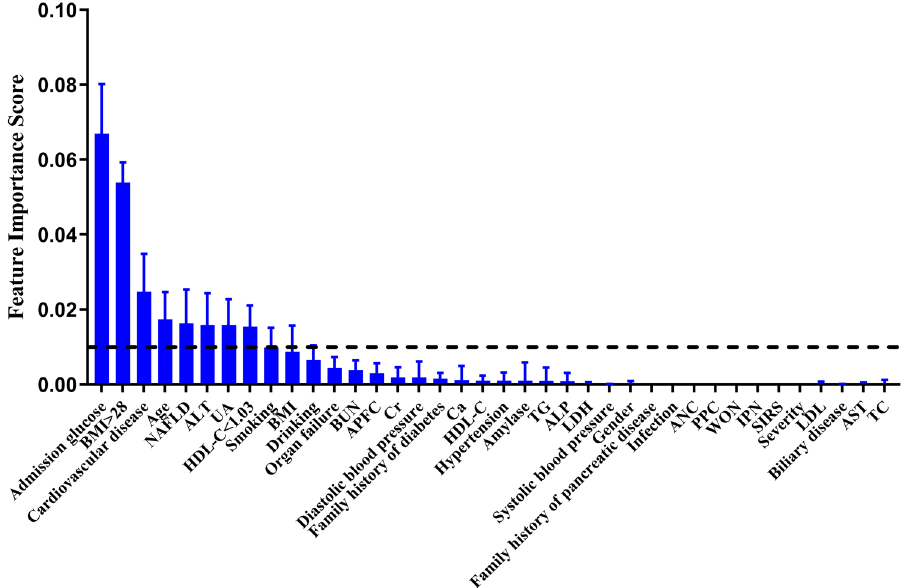
Figure 1. Core influencing factor screening. The mean values of the weights of the features were ranked by 1000 lasso regressions. Of these, nine features with Feature Importance Score > 0.01 were selected as core genes considered to be associated with